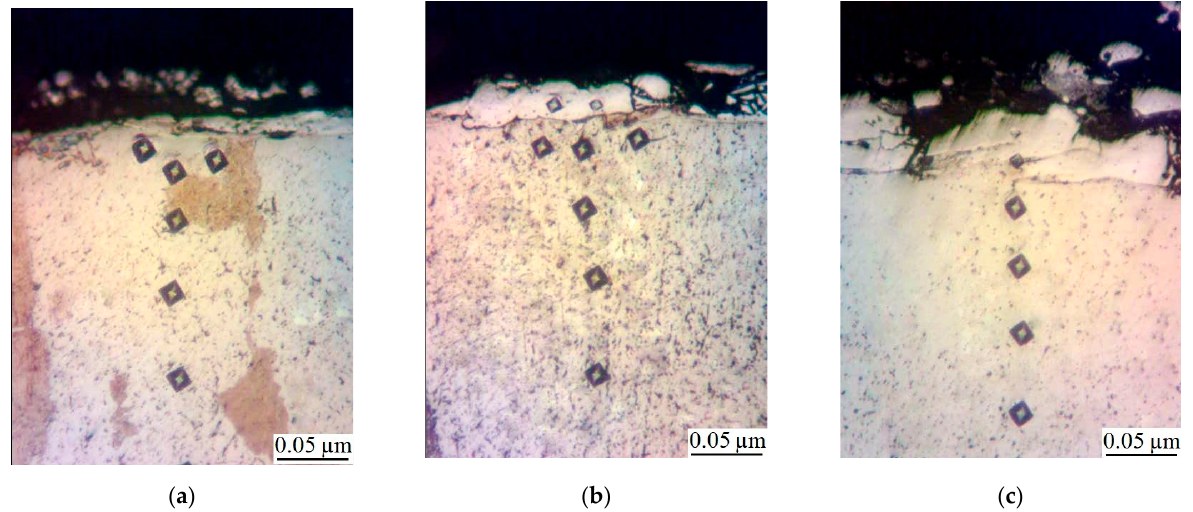
Figure 2. Microstructures in the surface layer of steel C22 after sulfomolybdenizing by ESA method: ( a ) Wp = 0.13 J; ( b ) Wp = 0.55 J; ( c ) Wp = 3.4 J.